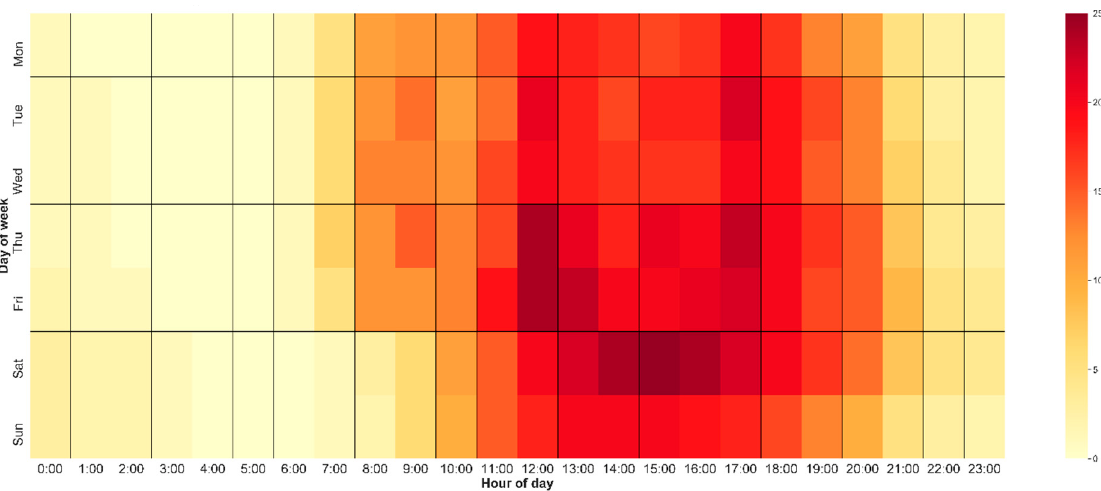
Figure 2. Heatmap of hourly E-scooter ridership (in thousands) in Austin, TX.